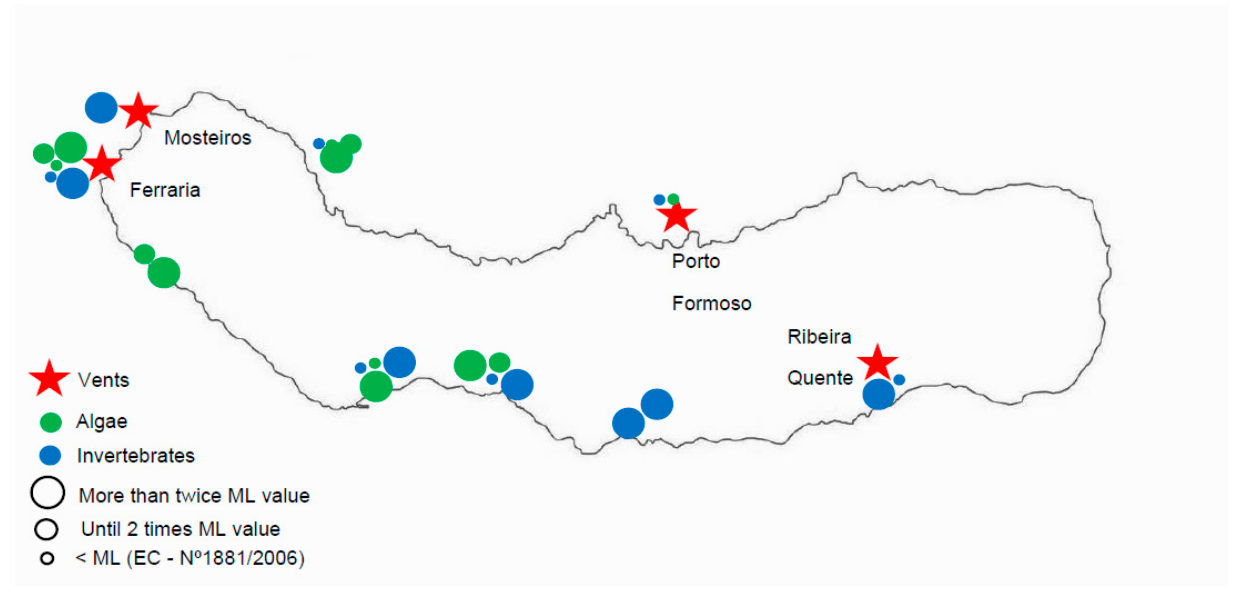
Figure 5. Location of studies on Cd content in São Miguel Island in algae (green color dots) and invertebrates (blue color dots). Stars represent the location of shallow water hydrothermal vents based on Couto et al. (2015) and the size of the dots represents the amount of Cd detected according to maximum legislated limits (ML); Regulation (EC) No 1881/2006: 0.05 (algae), 0.5 (crustaceans), 1 (mollusks) in mg kg − 1 wet weight.